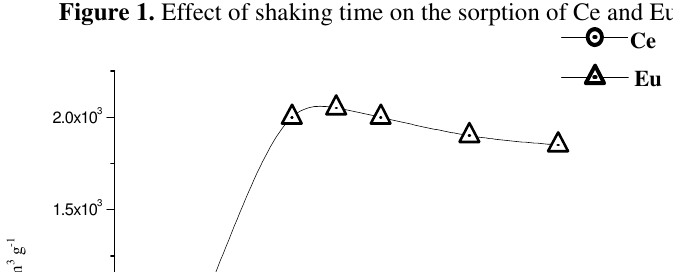
of Ce and Eu with adsorbent d